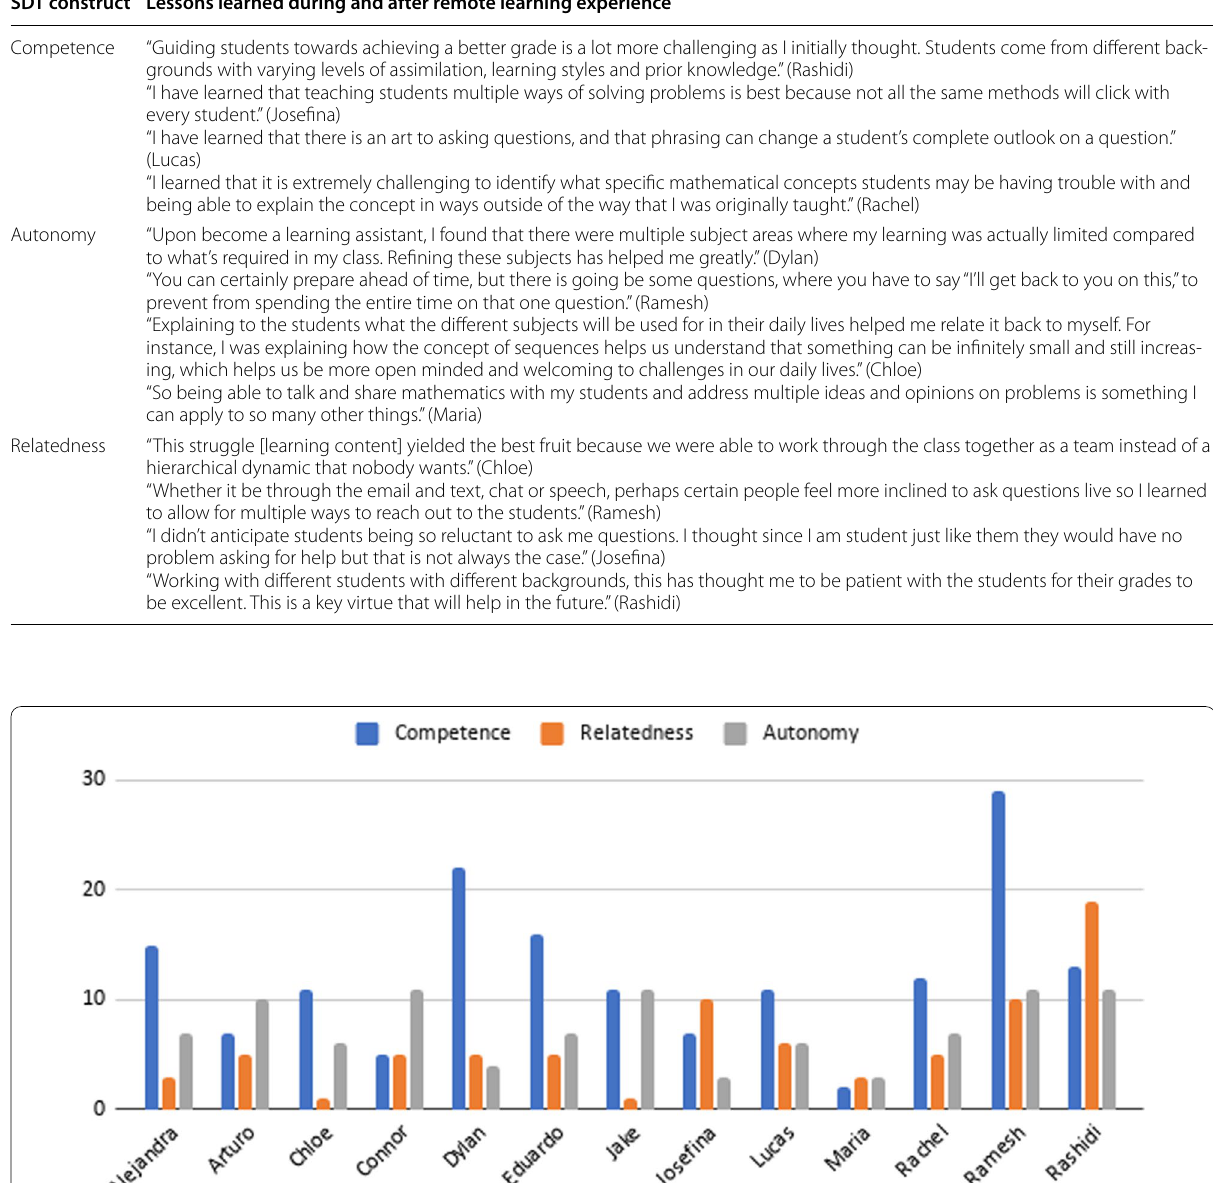
Table 4 Supporting quotations from LAs’ Questionnaire responses to the three constructs of SDT including lessons learned during and after remote learning transition